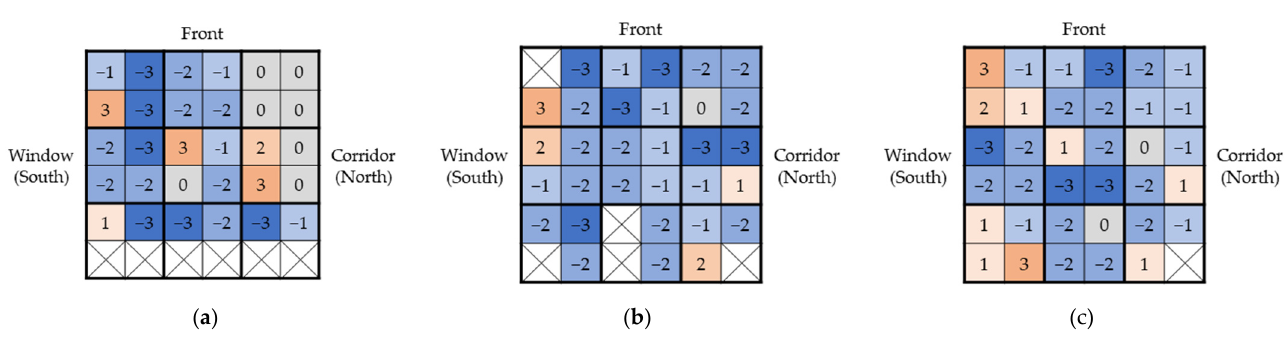
Figure 26. Summer AFSV result per seating point in ( a ) class A, ( b ) class B, and ( c ) class C.